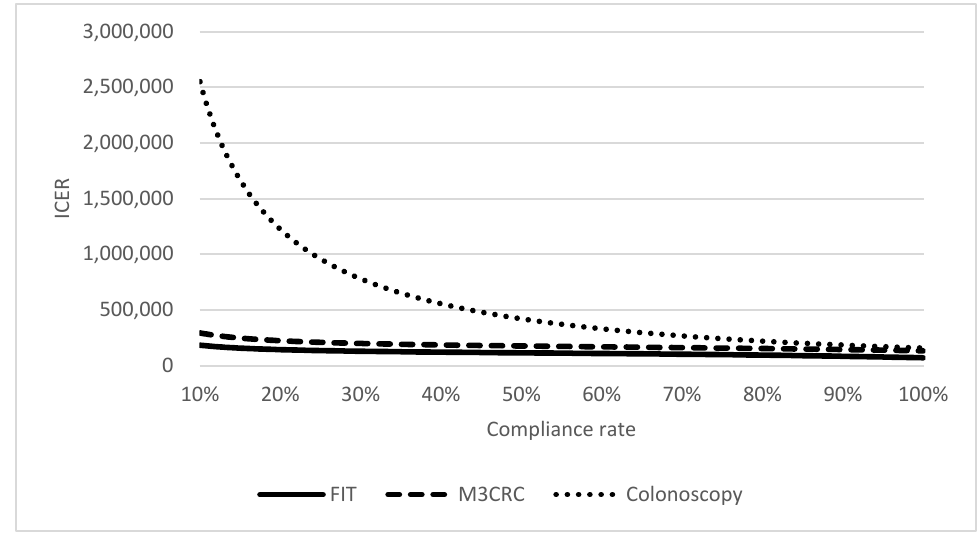
Figure 4. Two-way sensitivity analysis on the sensitivity and specificity of M3CRC.